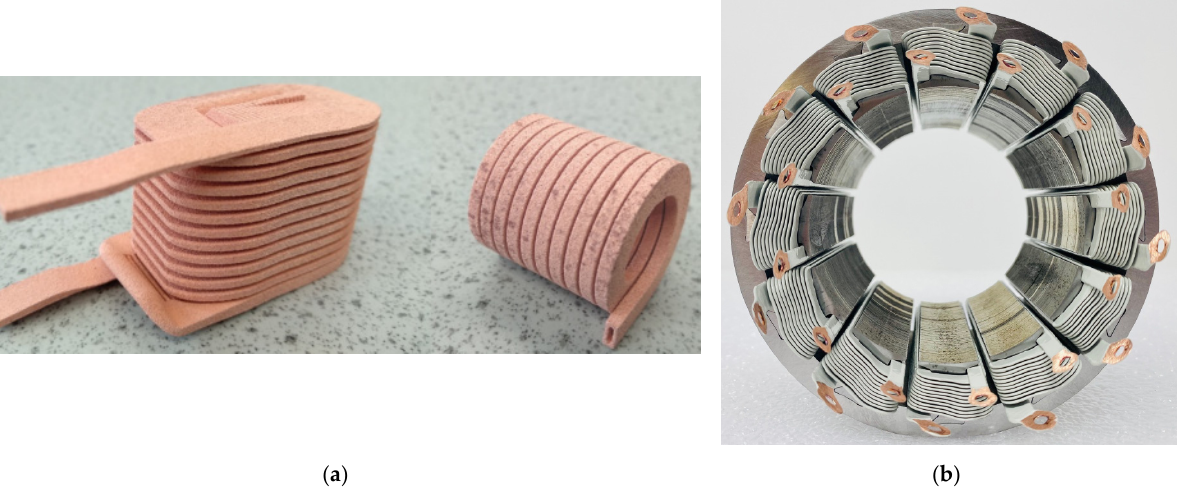
Figure 1. Concentrated coils made by AM technologies. ( a ) Samples made by laser PBF, reproduced with permission from the author of [90]; ( b ) coils used on a salient pole stator, reproduced with permission from the owner, Additive|Drives GmbH (Dresden) [93].